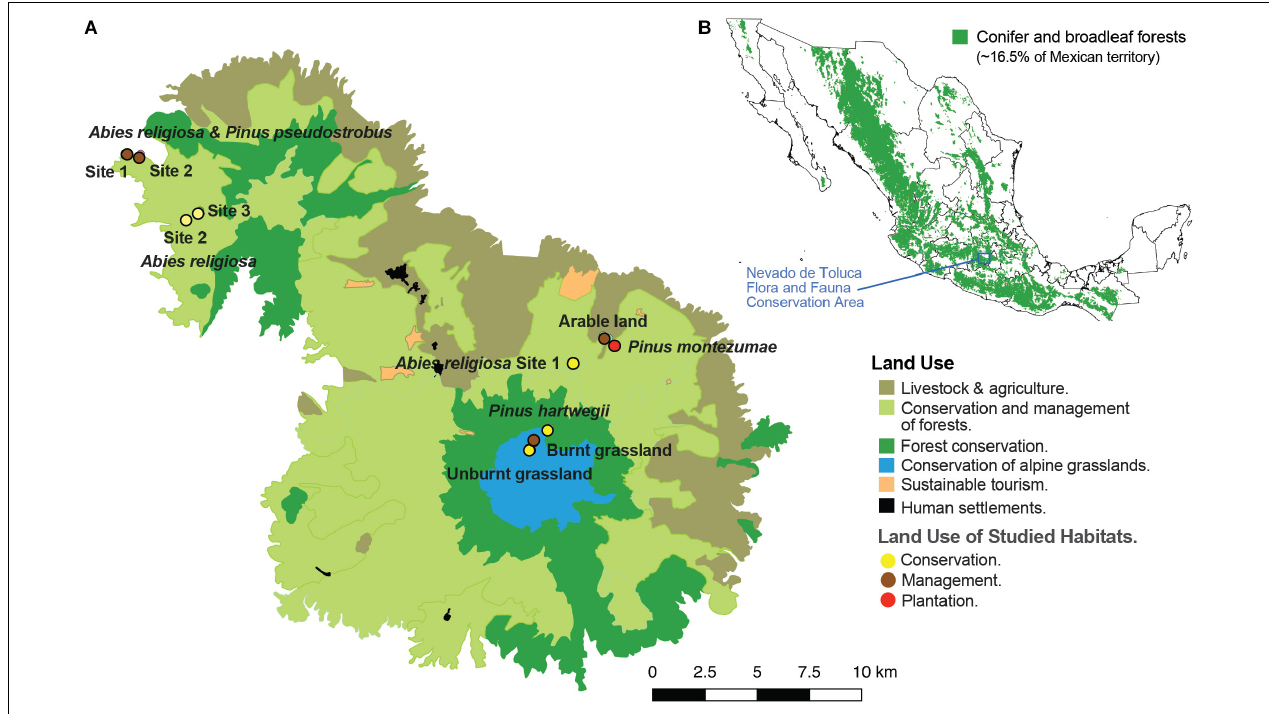
FIGURE 1 | (A) Habitats of study at the Flora and Fauna Conservation Area Nevado de Toluca, State of Mexico, Mexico. Our habitats were an unburnt and a burnt grassland at > 4000 masl, a natural P. hartwegii forest at 3960 masl, a P. montezumae plantation at 3284 masl, two managed A. religiosa and P. pseudostrobus forests at ∼ 2990 masl, three A. religiosa conservation forests at ∼ 3250 masl and an arable land at 3268 masl. (B) Conifer and broadleaf forests in Mexico occupy 16.5% of the territory. Alpine grasslands are highly vulnerable ecosystems and only cover 0.008% of the Mexican territory (Challenger and Soberón,